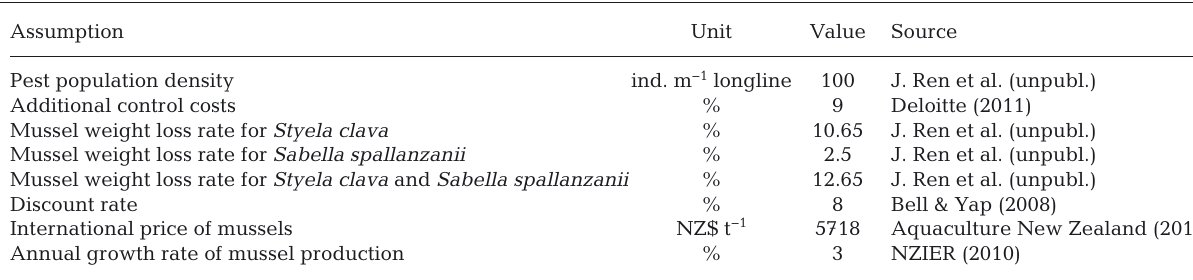
Table 2. Data inputs for the partial budgeting model used to estimate the direct economic impacts consisting of the market value of green-lipped mussel weight loss and the additional on-farm control costs that resulted from the presence of Styela clava and Sabella